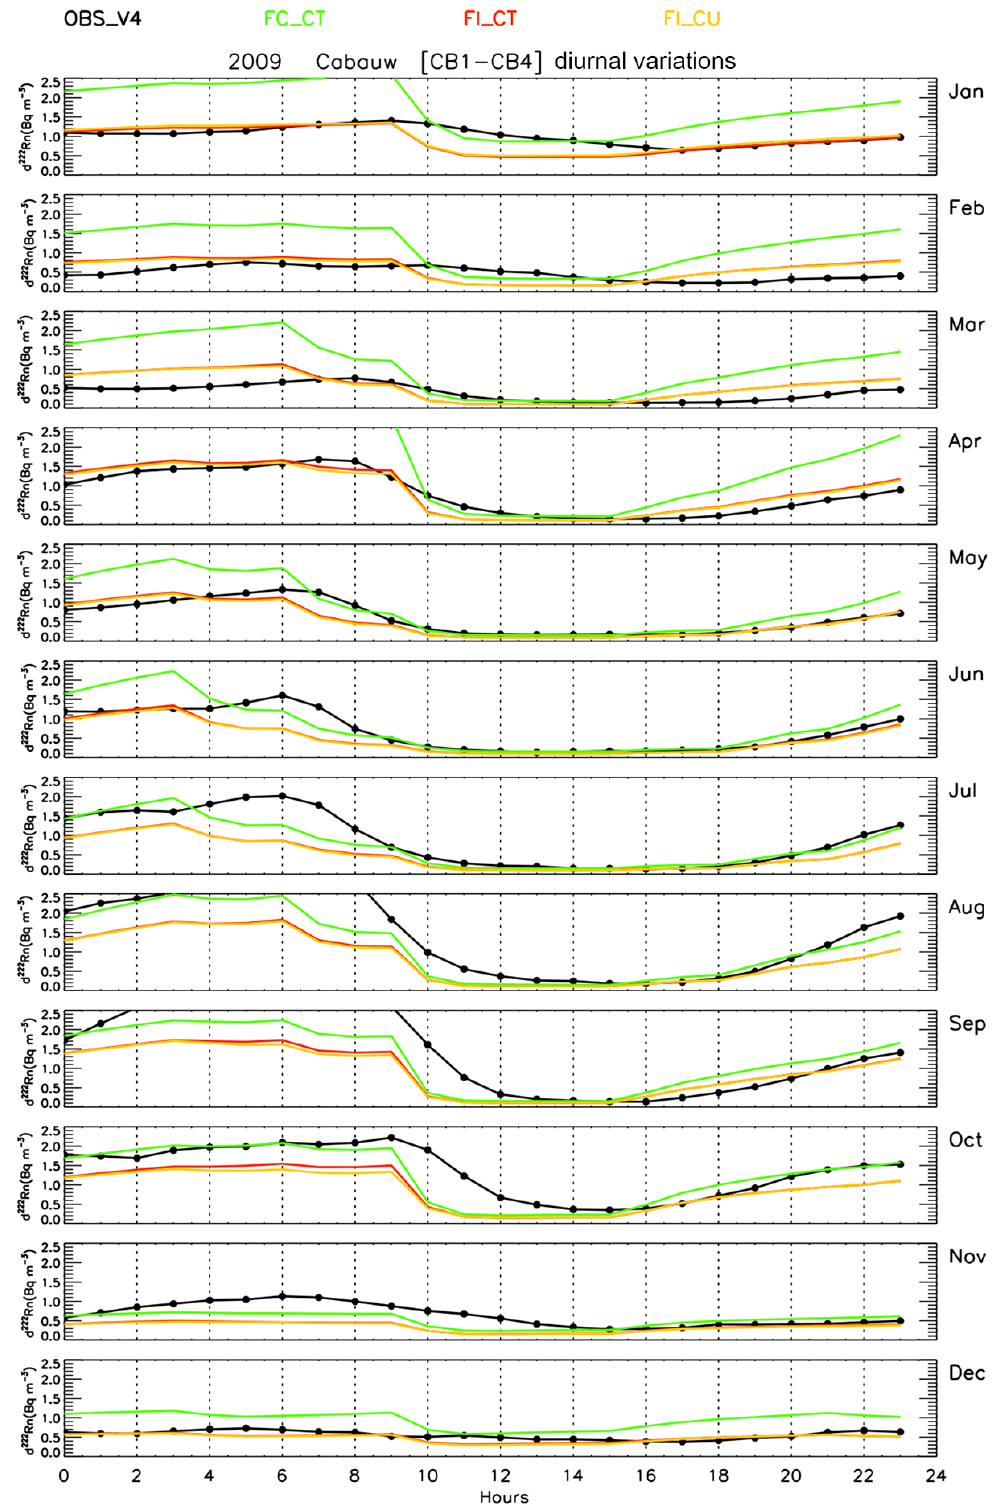
Figure 11. Mean diurnal variations of the radon activity concentration differences between the two measurement levels at Cabauw (20m (CB1), 200m (CB4)). The observed gradient is shown by the black solid line with dots (for each month of the year 2009), and the modelled gradient by the solid green line for the constant emissions (FC_CT), by the solid red line for the InGOS emissions (FI_CT), and by the solid orange line for the simulations using the InGOS emissions and the combination of the “revised slopes scheme” and the new convection scheme based on ECMWF reanalyses (FI_CU),